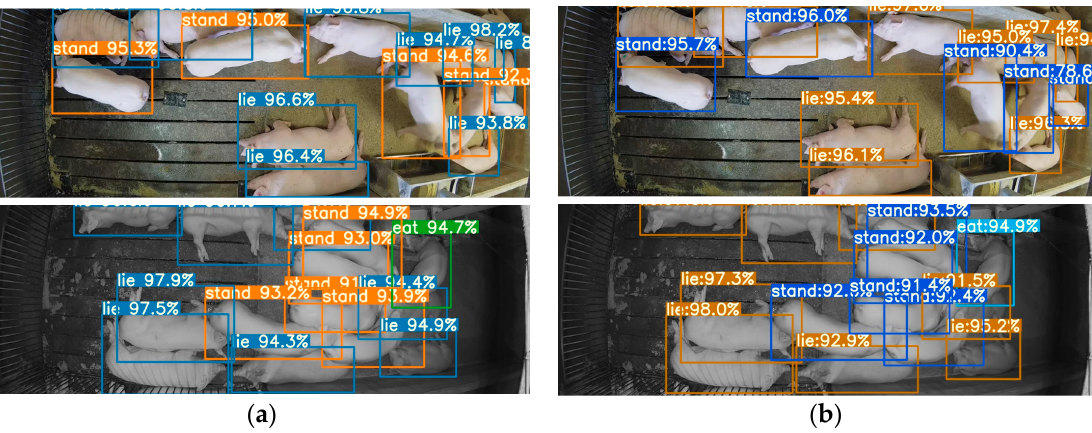
Figure 7. Detection performance of different detection models. ( a ) YOLO v5s and ( b ) YOLO X-S.